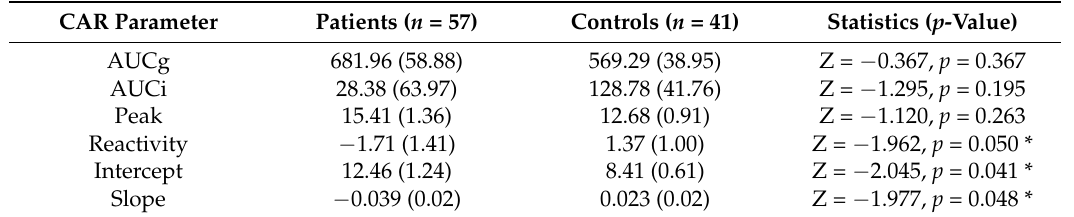
Table 3. Derived cortisol awakening response (CAR) parameters for MDD patients and healthy controls.